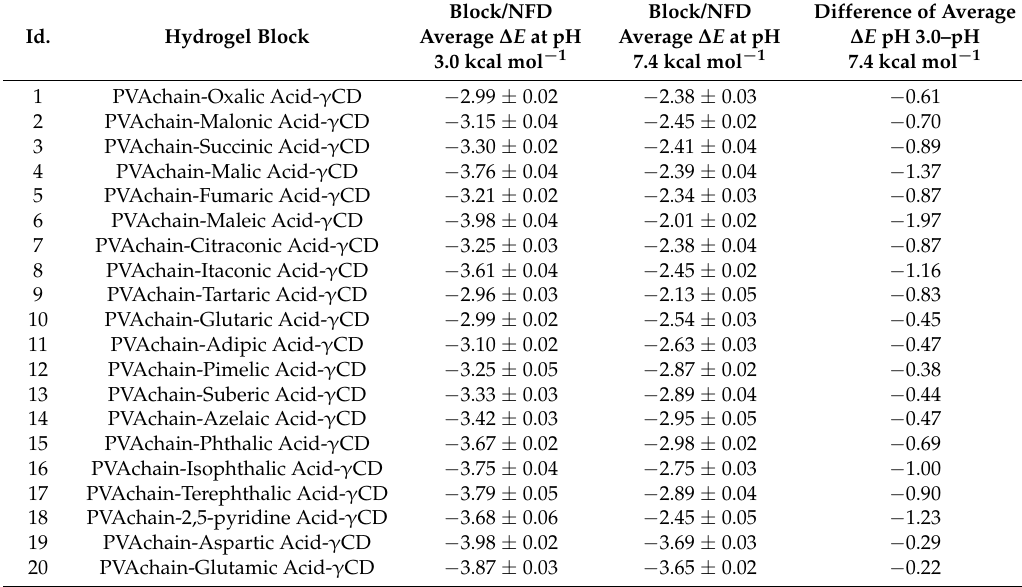
Id. Table 3. Average ∆ E values calculated using SQM methods between PVAchain-DCAs- γ CD block and NFD.